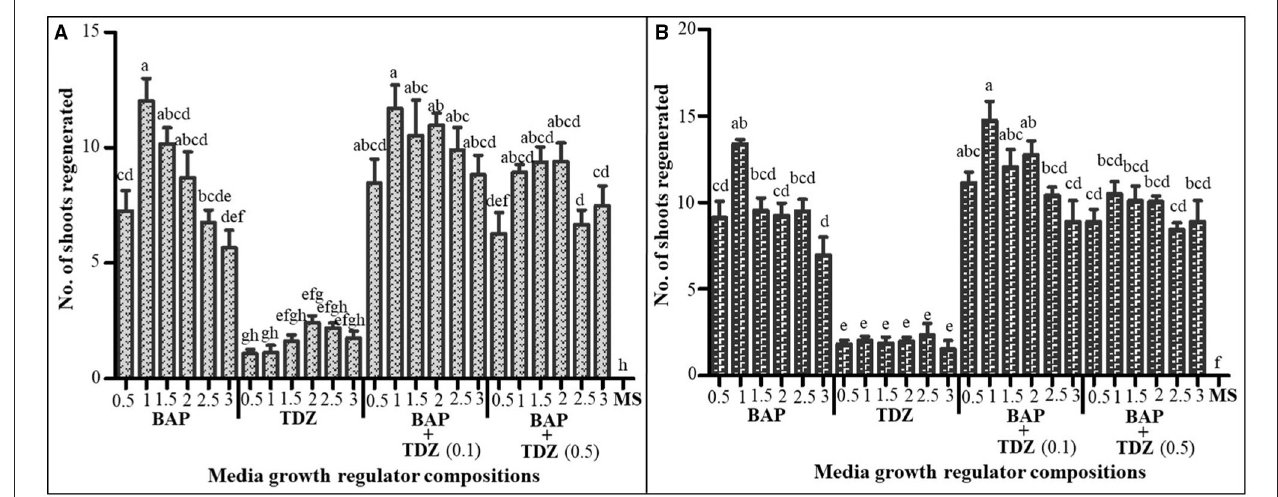
FIGURE 3 | The number of shoots regenerated from calli in MS medium supplemented with different plant growth regulator combinations (A) from leaf explant calli and (B) from root explant calli. All media contained 0.05 mg/L NAA, and all concentrations are in mg/L. Values are presented as means ± SE. The same letters are not significantly different by Tukey’s multiple comparison test and p =